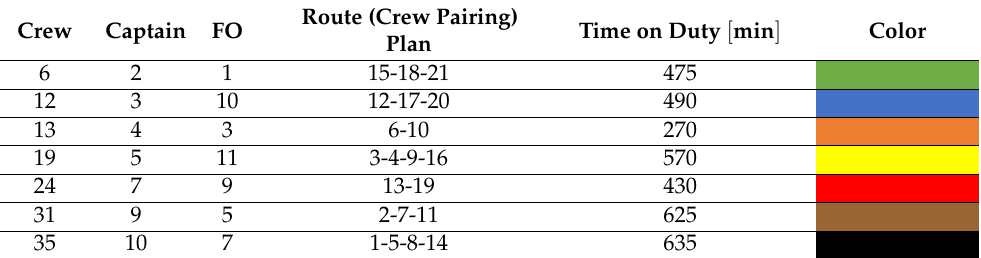
Table 11. Routes of active crews to service planned sets of flights.